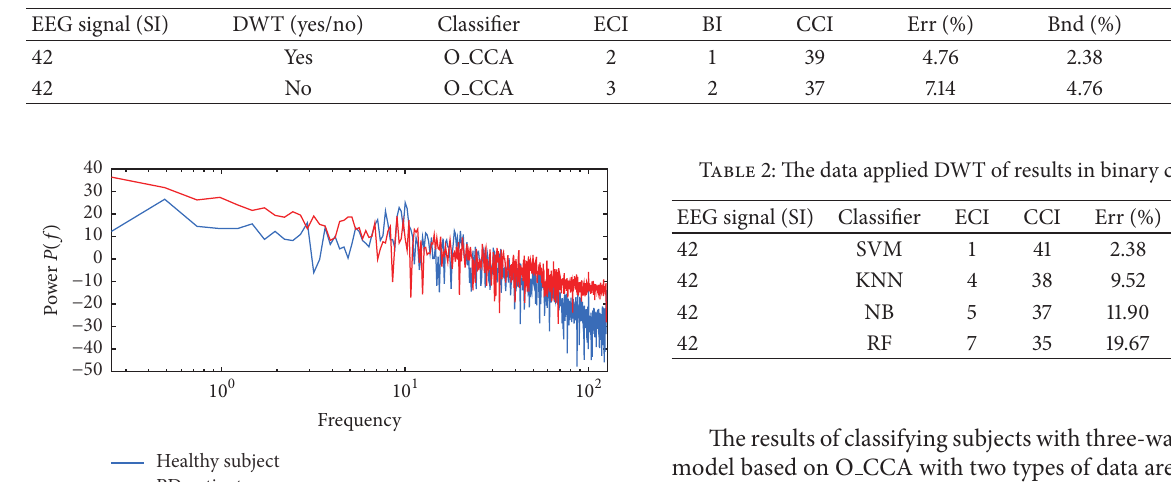
Table 1: Results of classification from the O CCA classifier model.